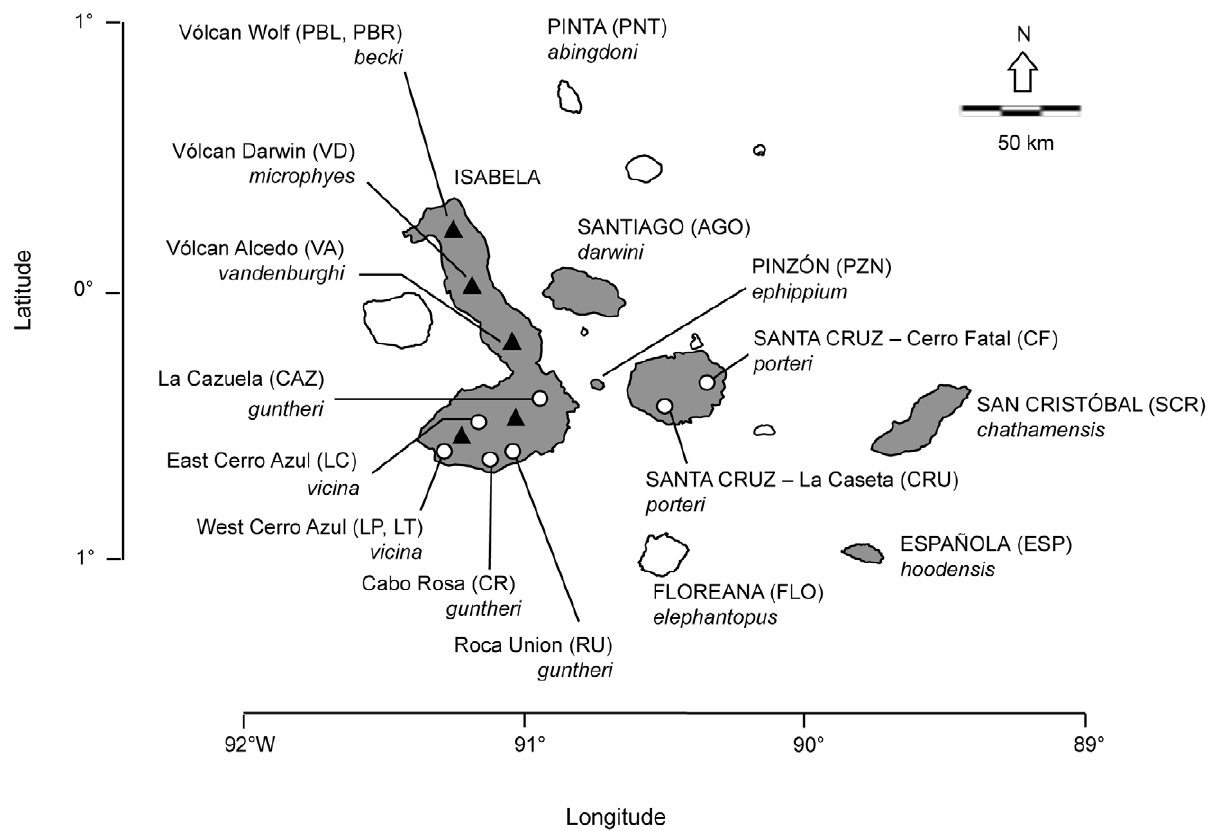
Figure1.DistributionofgianttortoisesthroughouttheGala´pagosarchipelago. Islandnames arecapitalized;shadedislandsindicatepresence of extant tortoise populations(species names italicized). Populationsare indicated by geographical name (e.g., Vo´lcan Wolf) and associated samplingsite (e.g., PBL, PBR). Triangles represent volcanoes on Isabela Island and circles indicate additional sampling locations. Figure modified from Russello et al. [5].